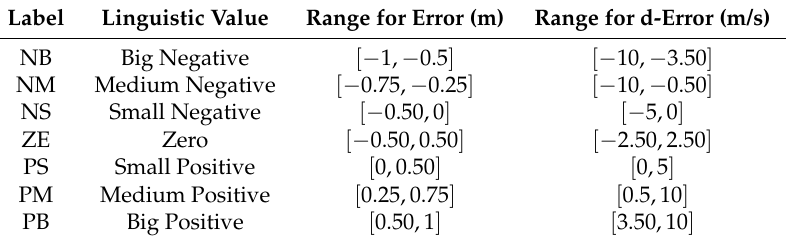
Table 1. Linguistic values for range of error and the derived of